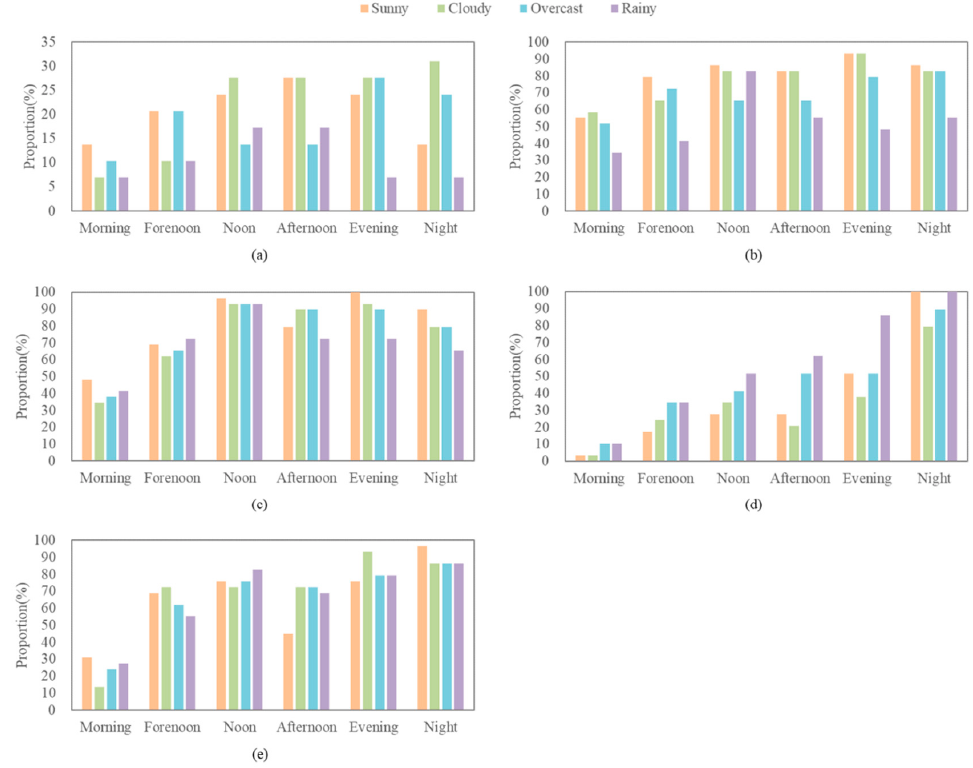
Figure 1. The opening ratio of ( a ) a balcony door, ( b ) window, ( c ) curtain, ( d ) dormitory light, and ( e ) table lamp of people in isolation during different periods and in different weather conditions.